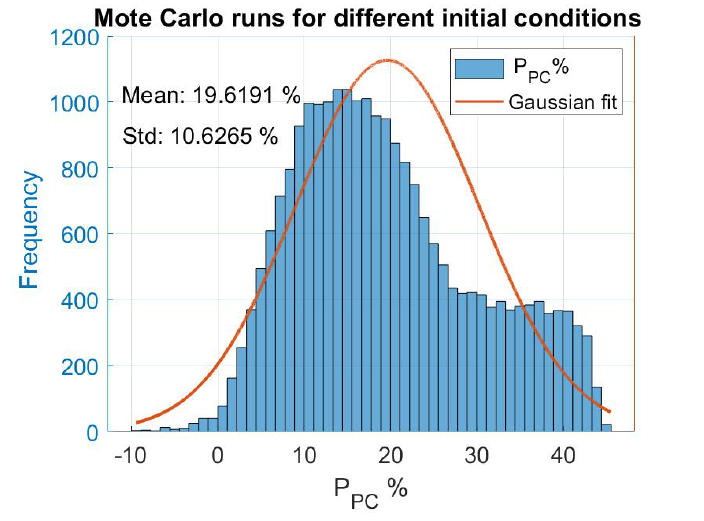
Figure 13. Gaussian distribution and histogram of improvement percentage in power consumption.